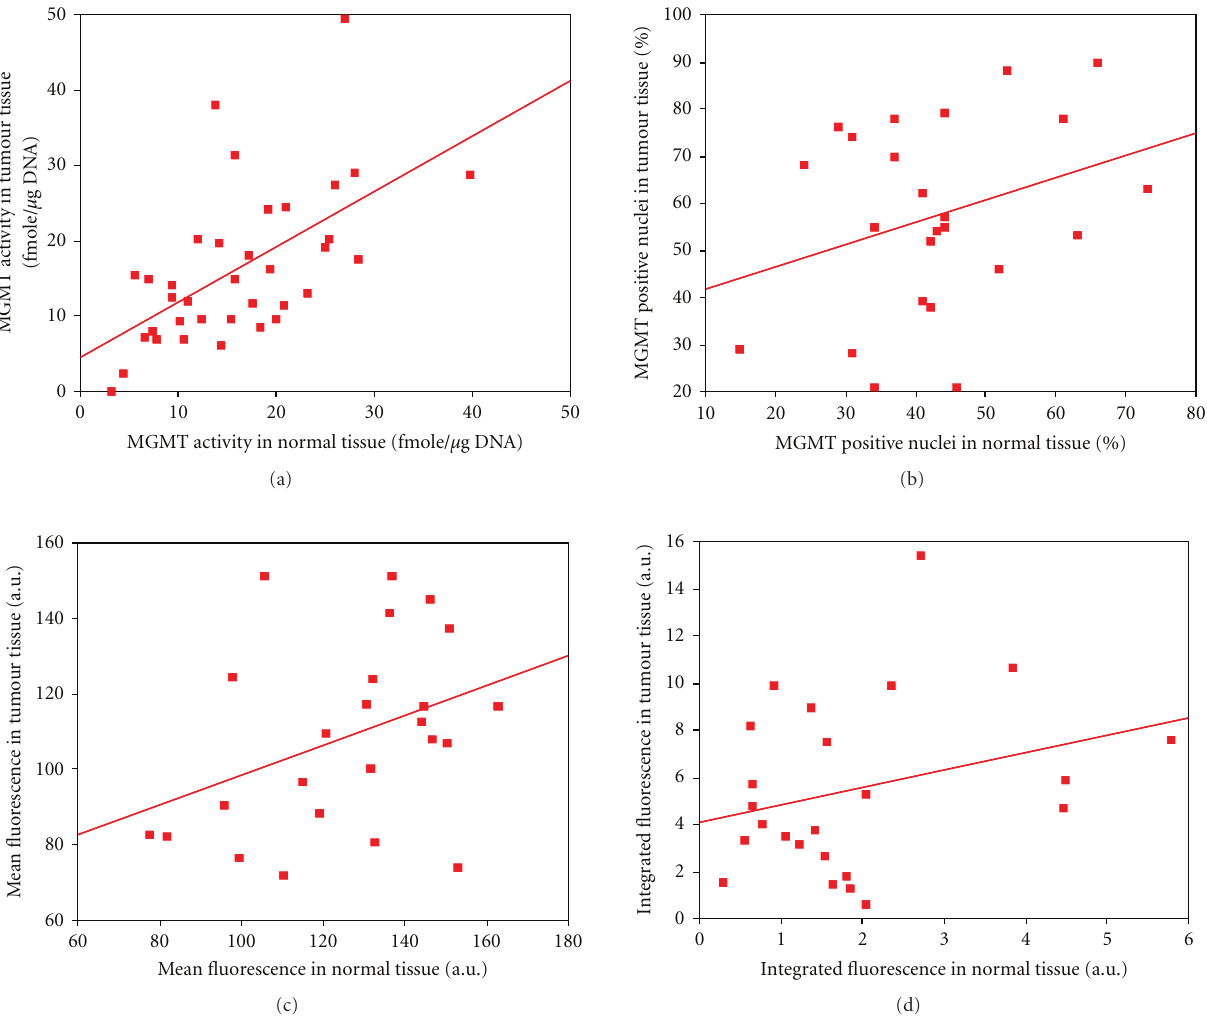
Figure 6: Relationship between tumour and normal tissue MGMT activity (fmoles/ug DNA, (a)), % positive nuclei (b), mean fluorescence (c) and integrated fluorescence (d), parameters of MGMT content.